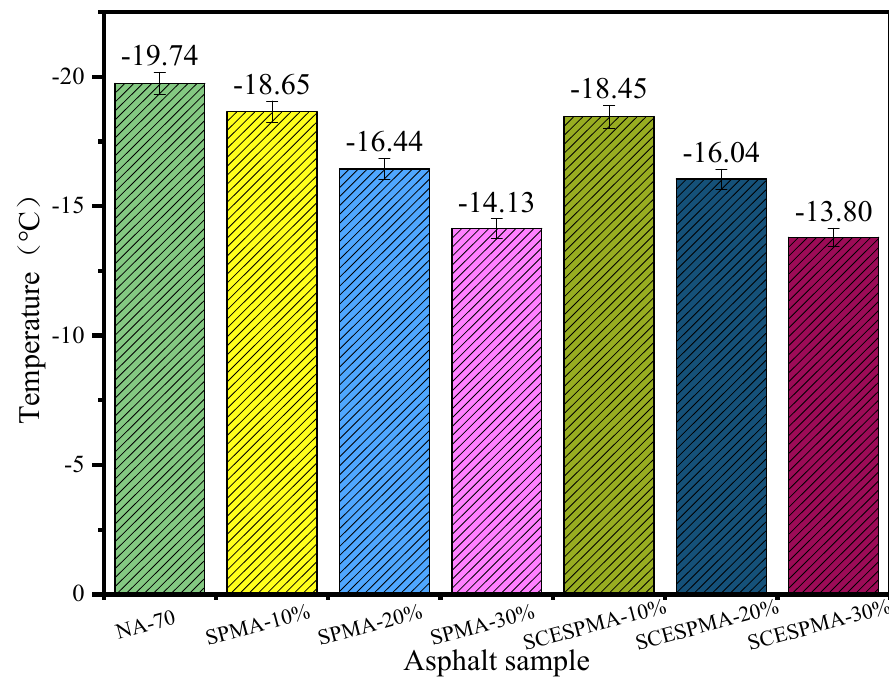
Figure 15. Continuous low-temperature PG analysis of SPMA and SCESPMA.